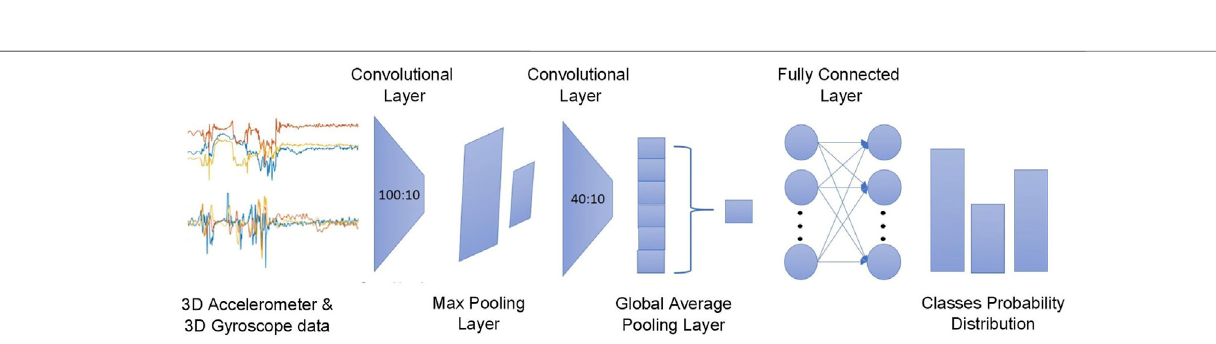
comparisons between the CNN and the traditional classi fi ers are also presented below in Table 2 . The speci fi city and sensitivity were reported to be equal to 88 and 83%, for LOSO-CV, and 90 and 86%, for 10-CV, respectively. Results for patient-speci fi c